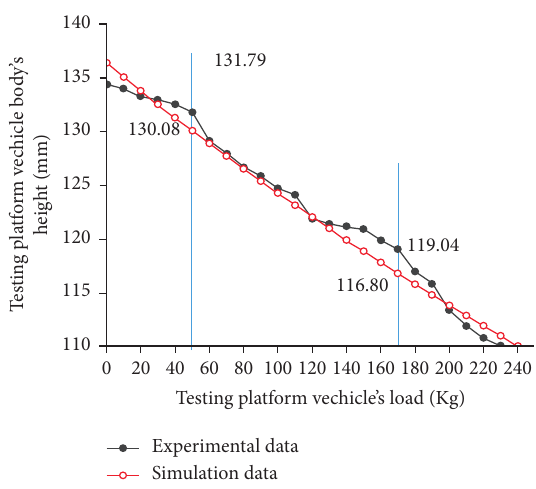
Figure 12: Comparison of the simulations and experiments of the vehicle body’s height versus the vehicle loading conditions.